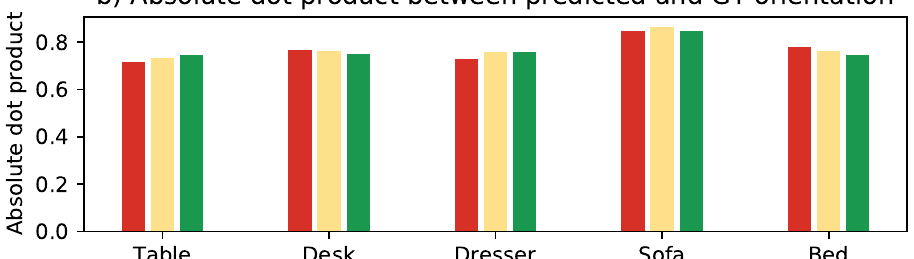
Desk Dresser Sofa